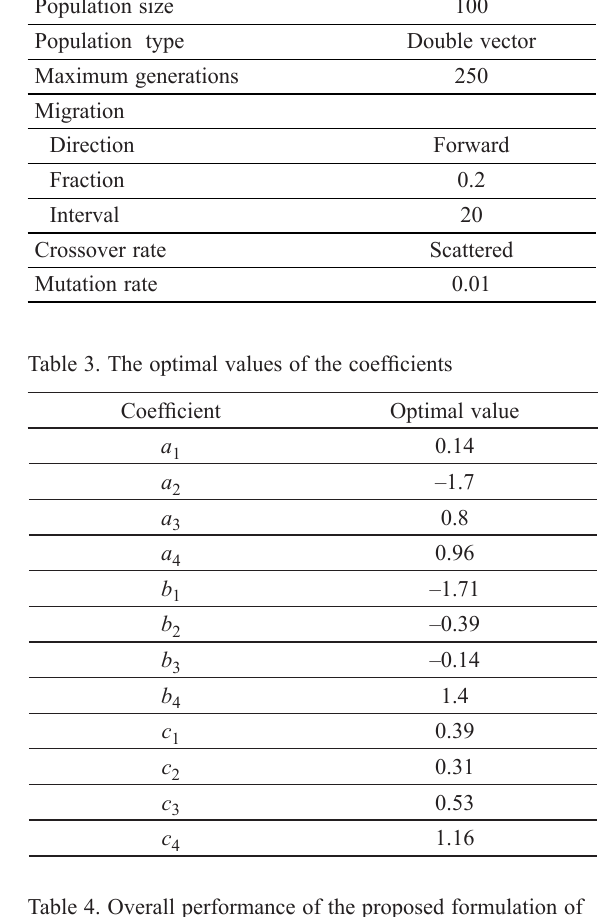
Table 4. Overall performance of the proposed formulation of the normalized strain–stress relationship Model